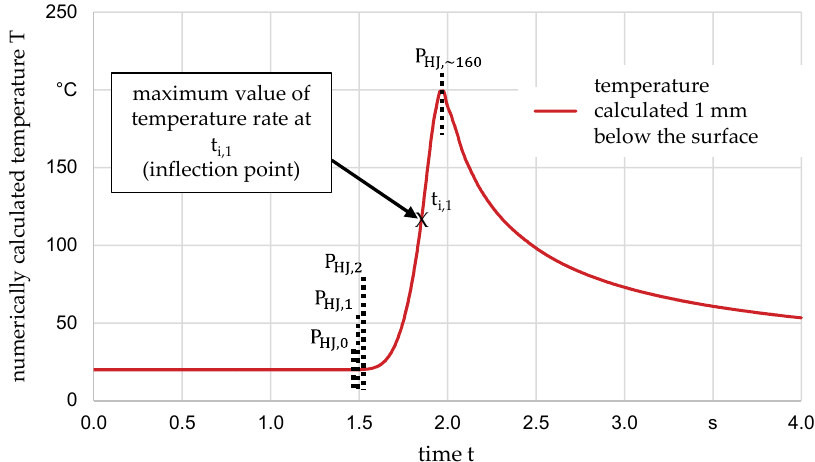
Figure 13. Incremental calculation of the Hollomon–Jaffe parameter P HJ depending on the time temperature development. In the incremental description of the Hollomon–Jaffe parameter, the temperature in- crease and the time in which this increase occurs are taken into account in each incremen- tal time interval, whereas the maximum temperature rate only represents the temporal behavior at the inflection point of the temperature-time curve. As the initial condition, the Hollomon–Jaffe parameter is set at P HJ,0 = C × T 0 with the constant characteristic of the material being C = 18.69 [31] and the starting temperature T 0 = 294.15 K, which corre- sponded to the ambient temperature. Each time increment of ∆ t = 0.004 s, the Hollomon–